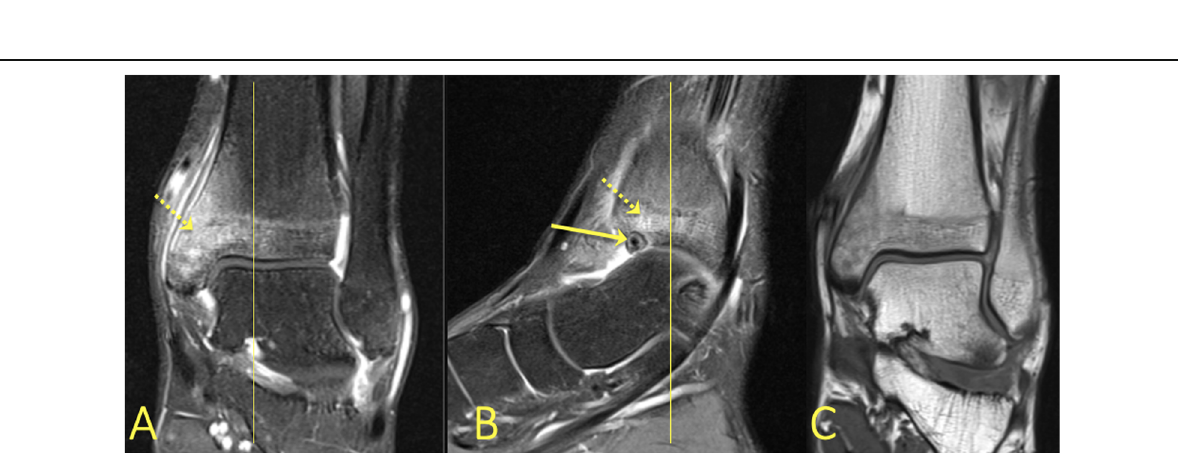
Fig. 31 A 19-year-old male presented with nightly ankle pain. MRI confirmed a suspected osteoid osteoma, showing an intra-articular osteoid osteoma (arrow) with minimal sclerosis and extensive BME (dashed arrows) as a perilesional reaction